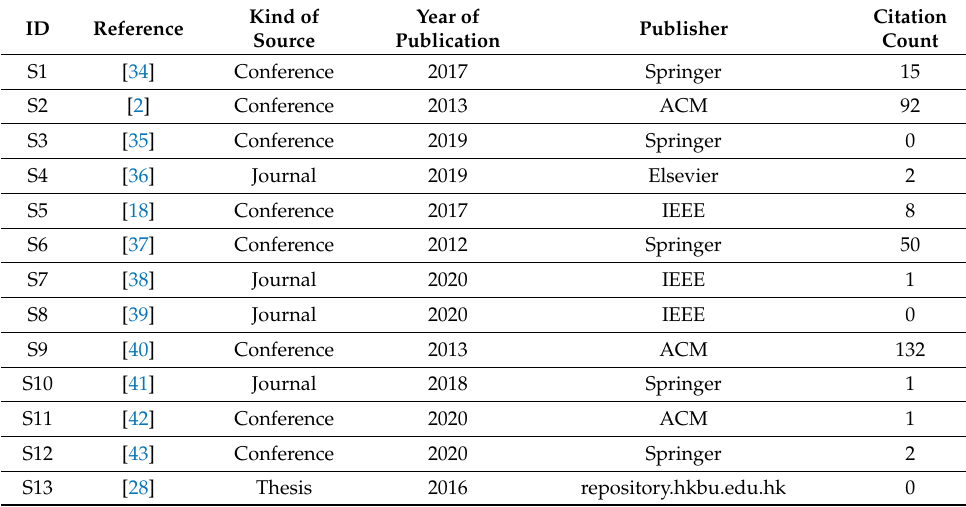
Table 5. Overview of the selected